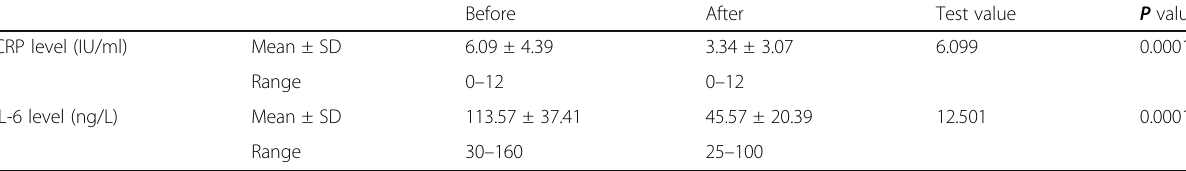
Table 3 Serum IL-6 and CRP before and after receiving colchicine treatment in the patient group Before